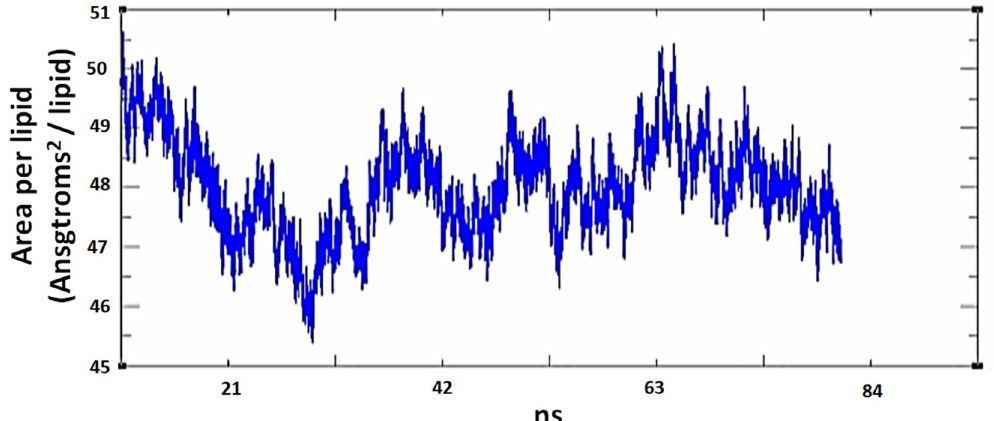
Figure 6. Area per lipid for PLASM-IU5-like membrane. As shown in the graph, it tends to be stable along the trajectory. This parameter was similar for all of the rest of the membranes simulated. Obtained with